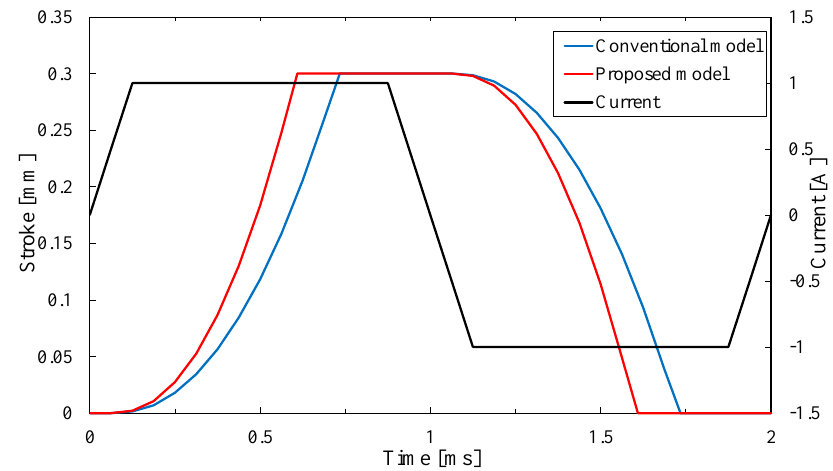
Figure 10. Response waveforms of the conventional model and proposed